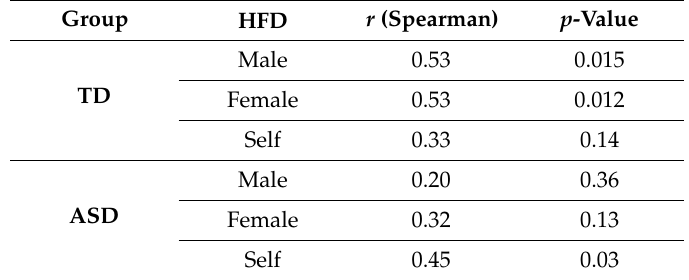
Table 2. Spearman correlation analysis between maturity and a ff ect recognition scores, reporting ( r ) and p -values in the TD and ASD groups. Significant correlations ( p < 0.05) are highlighted in grey. Group